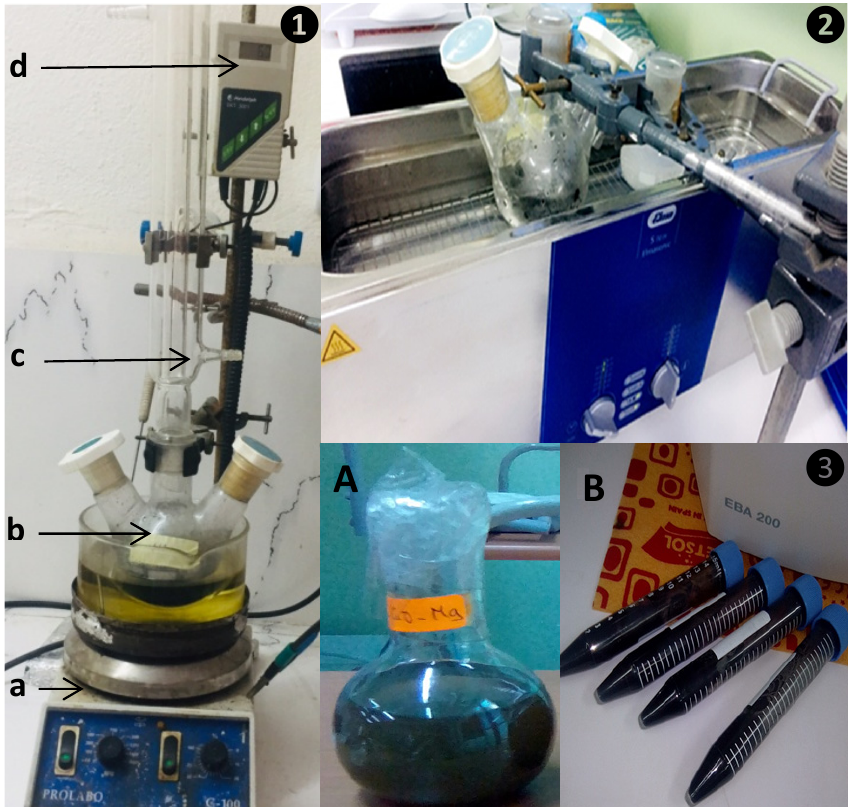
Figure 1. GO and MgO–rGO nanocomposites synthesis steps: ( 1 ) Separate sonication of DE:GO and DMF:HMg solutions; ( 2 ) MgO–rGO reflux synthesis (a—stirrer, b—flask, c—cooler, d—temperature regulator); ( 3 ) MgO–rGO solution ( A ) and MgO–rGO powder after washing and centrifugation ( B